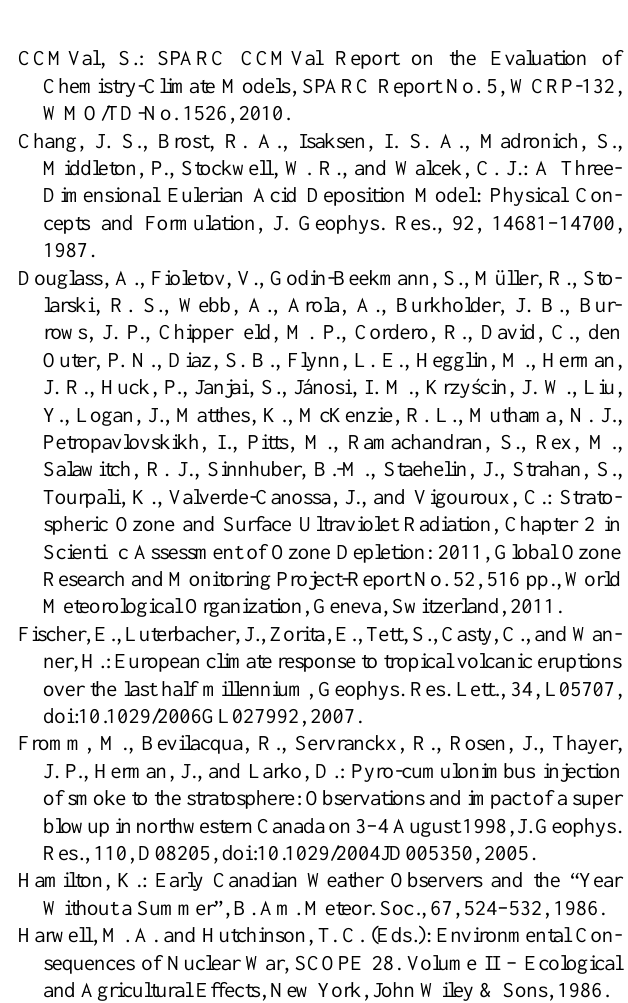
Fig. 14. Zonal mean total column ozone column [ DU ] averaged over the second year following the nuclear war as a function of geograph- ical latitude for the CTRL simulation (grey) and the soot simula- tions (color code see legend). The dashed black line shows results by Mills et al. (2008, their Fig. 3). The dotted line indicates ozone hole conditions (220DU).